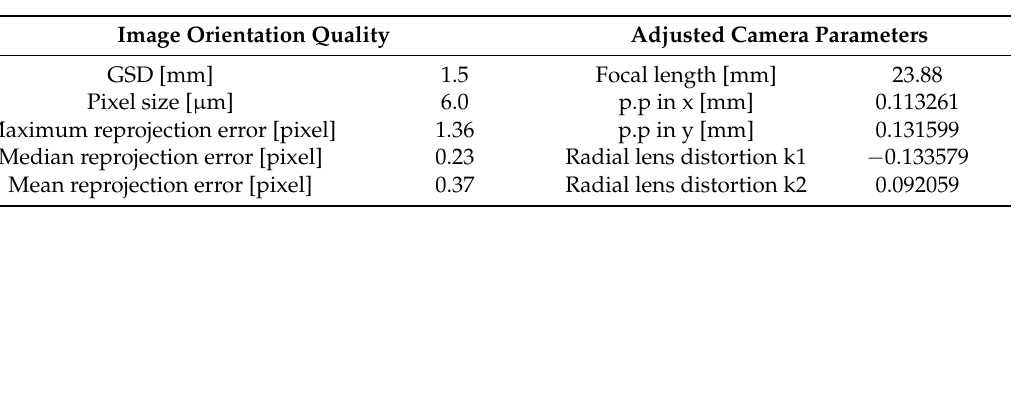
Table 1. Camera specifications and image orientation quality of the first